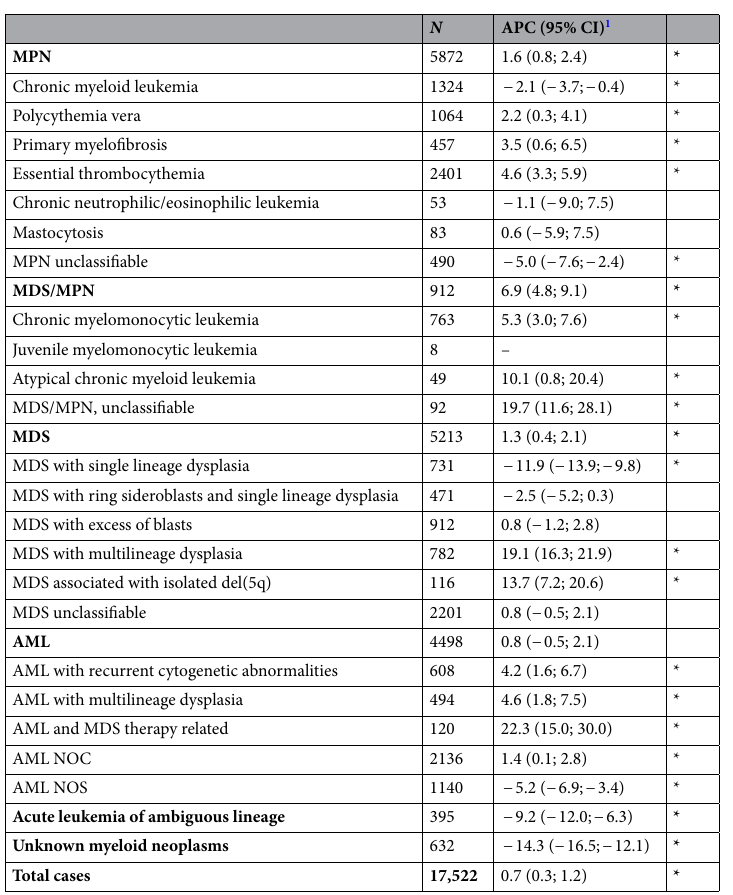
neoplasms, MDS myelodysplastic syndromes, MN myeloid neoplasms, NOC not-otherwise categorized, NOS not-otherwise